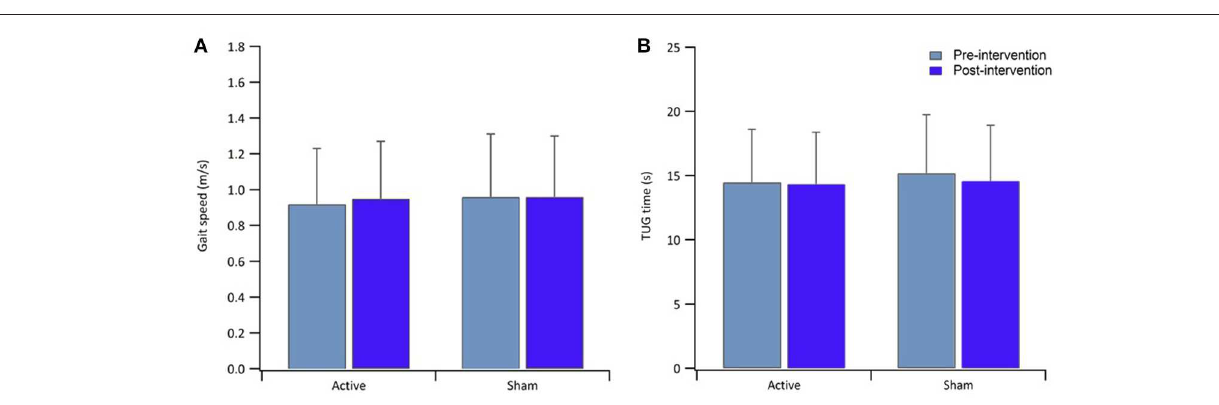
FIGURE 2 | Bar graphs show result of gait speed (A) and TUG time (B) for the active and sham group, pre-intervention (light blue) and post-intervention (blue). Error bars in both graphs indicate ±